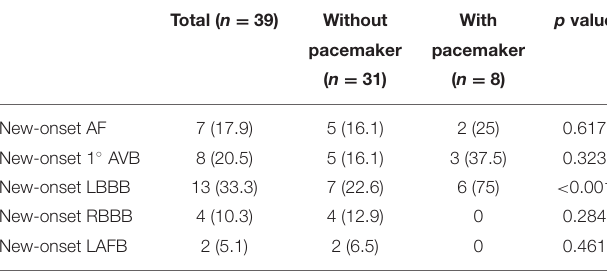
TABLE 3 | Procedural related electrocardiographic conduction disturbances. Total ( n = 39) Without